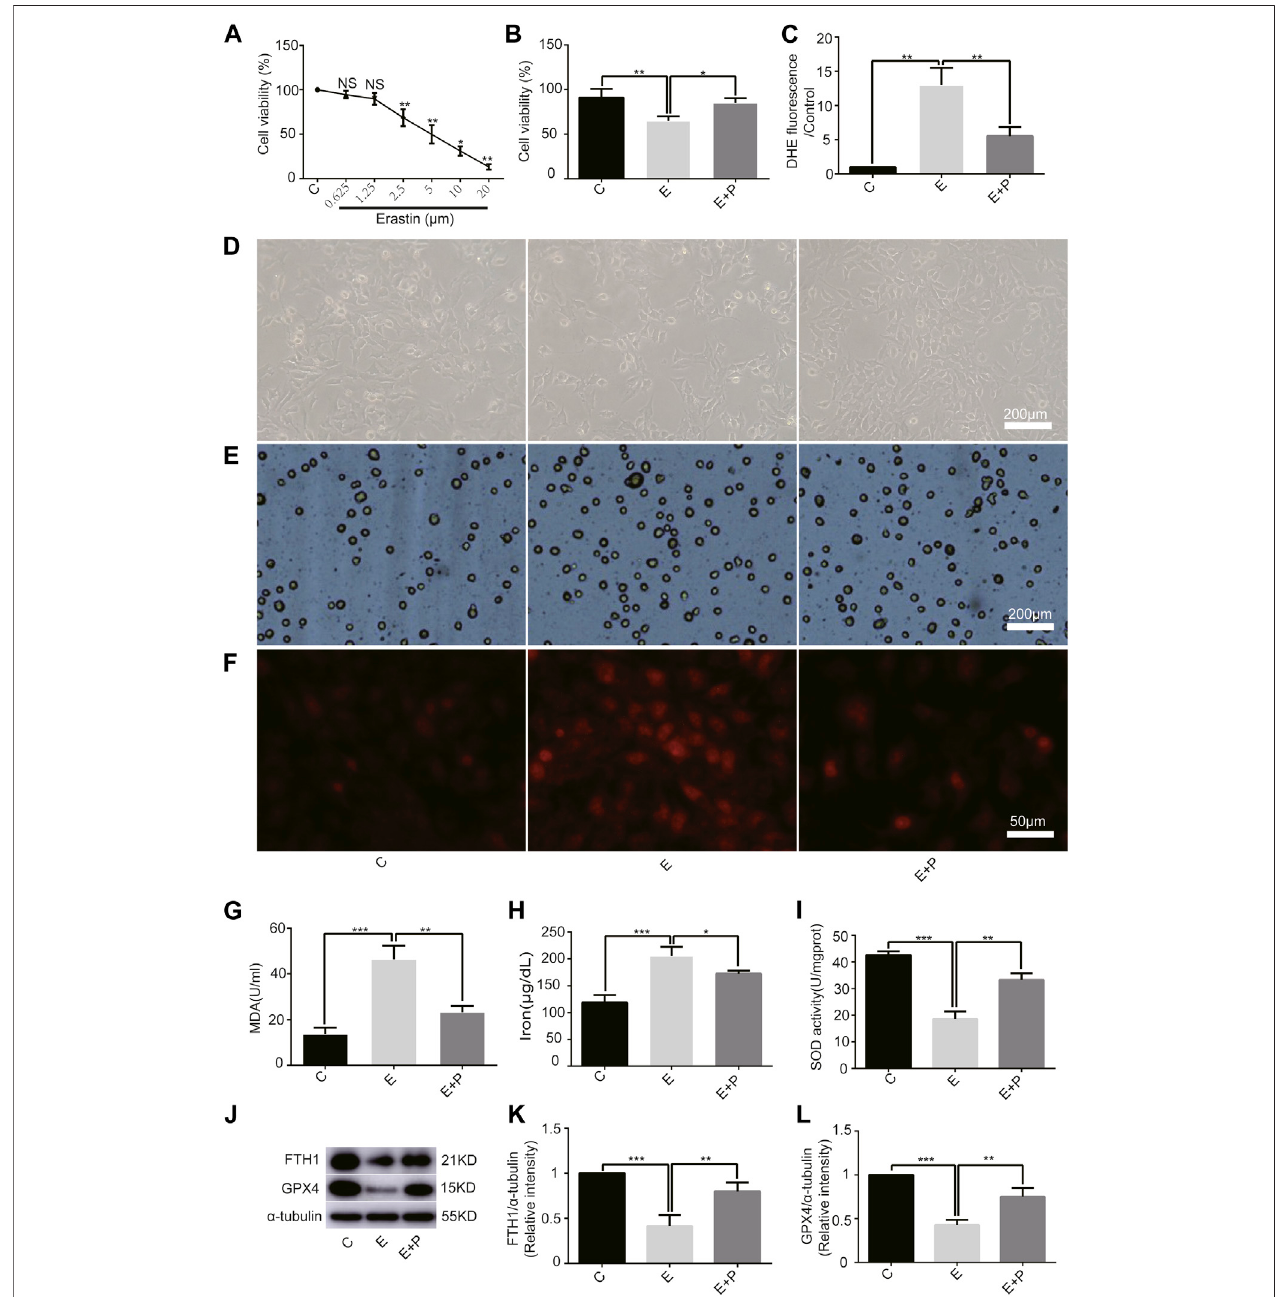
FIGURE2| Effect ofpropofol onerastin-induced H9C2cellferroptosis. (A) .CellviabilityofH9C2cellstreatedwitherastin(0 – 20 μ M). (B,D,E) :Effectofpropofol on erastin-induced cell death. Dead cells were stained with trypan blue. Scale bar: 200 μ m. (C , F) : Effect of propofol on reactive oxygen species (ROS) production. Quanti fi cationofROSisexpressedasDHE.Scalebar:50 μ m.EffectofpropofolonMDA (G) ,iron (H) ,andSOD (I) production. (J – L) :In fl uenceofpropofolonantioxidant enzymes (FTH1 and GPX4). N = 3. Data are expressed as the mean ± SD. Signi fi cance was calculated using one-way ANOVA with Tukey ’ s post hoc test or the t -test. p -values < 0.05 were considered statistically signi fi cant. * p < 0.05, ** p < 0.01, *** p < 0.001.